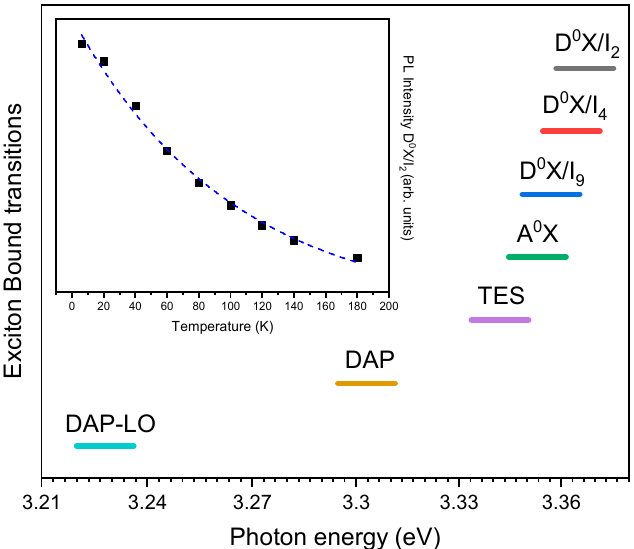
Figure 4. The exciton-bound transition energy reported in [66] at 6 K. D 0 X (denotes exciton bound to neutral donors), A 0 X (exciton bounded to a neutral acceptor), TES (two-electron satellite transition), DAP (donor-acceptor pair transitions), and DAP-LO (first-order longitudinal optical). Quenching e ff ect of the D 0 X / I 2 emission as the temperature is increased from 6 to 180